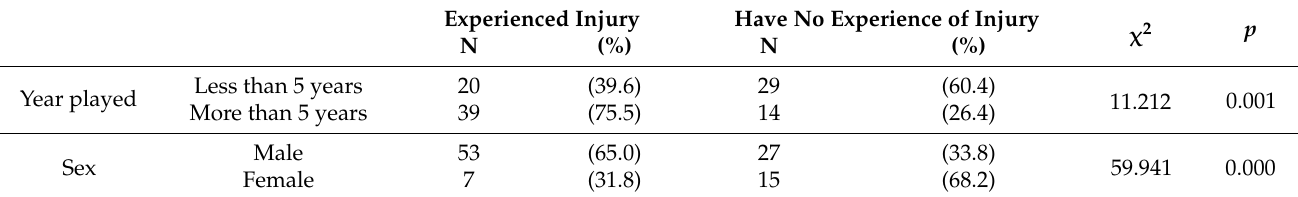
Table 4. Injury Experience based on Years Played and Sex of